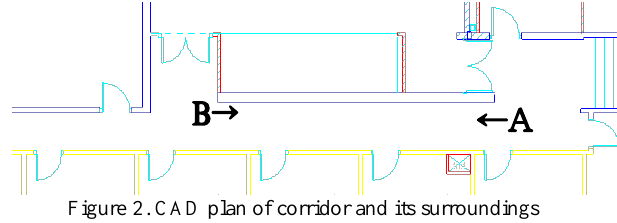
Figure 2. CAD plan of corridor and its surroundings